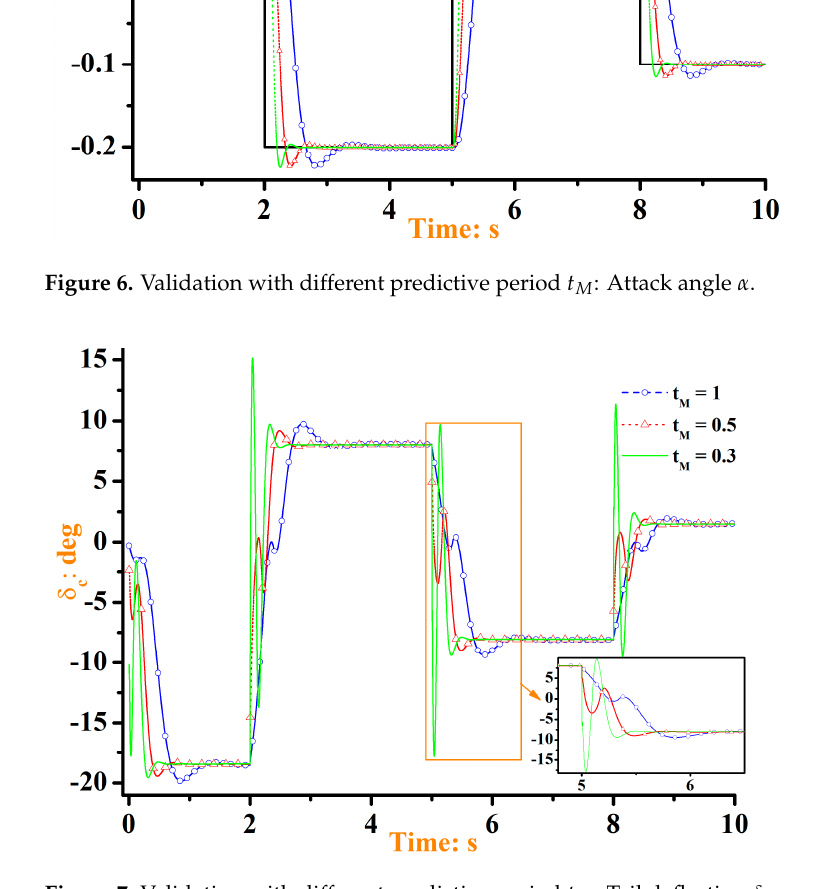
t : Tail deflection M δ .